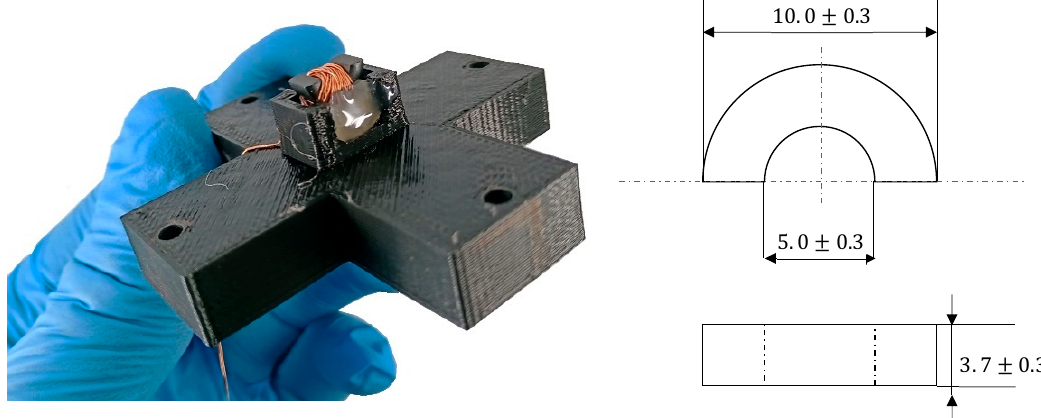
Figure 6. Photo and dimensions of the directional MIP sensor.